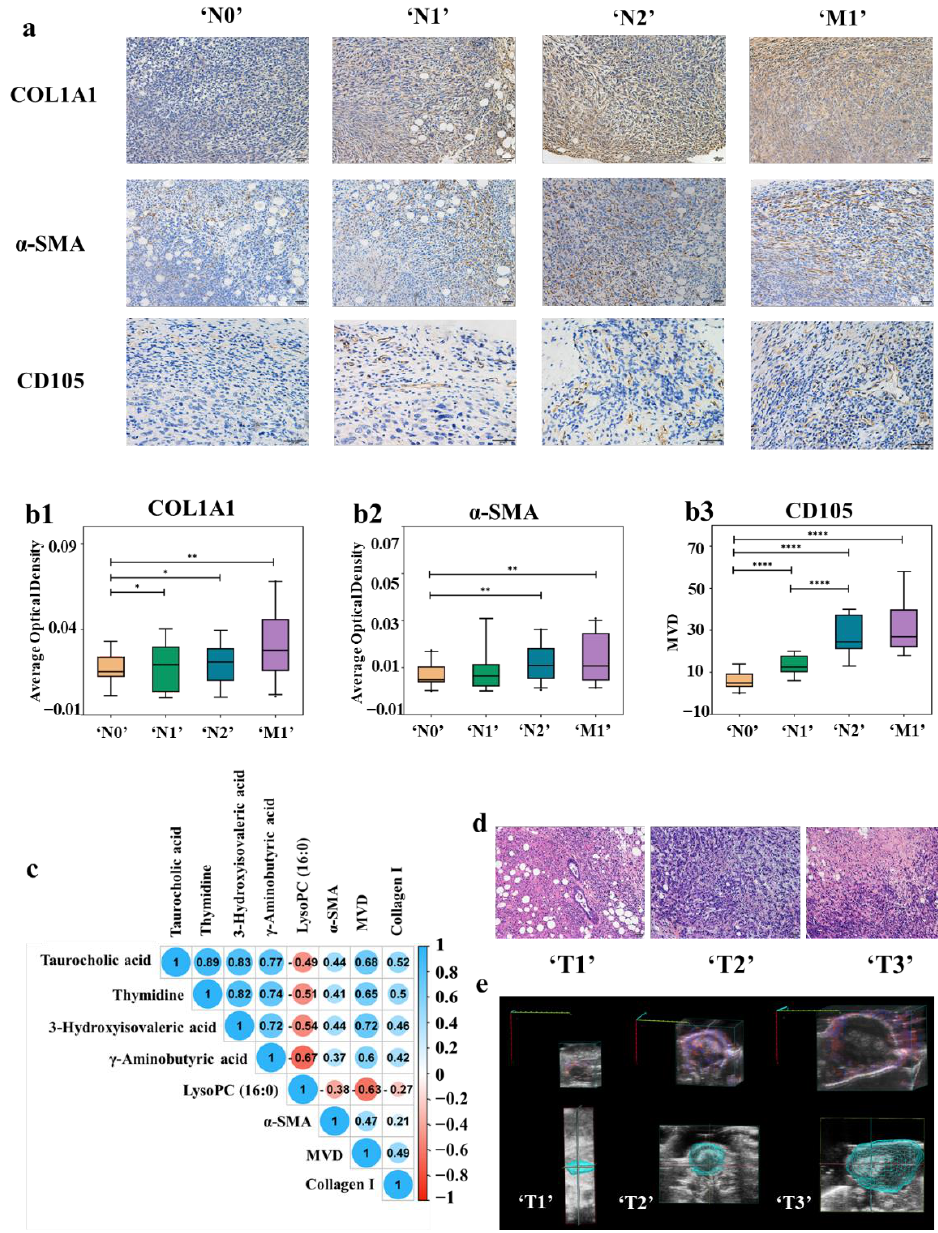
Figure 4. ( a ) Immunohistochemistry with anti-collagen I, anti- α -SMA, and anti-CD105 antibody in tumor tissues of ‘N0’ ( n = 11), ‘N1’ ( n = 8), ‘N2’ ( n = 14) and ‘M1’ ( n = 12) stages BC mouse model. With the deepening of the degree of tumor metastasis, the expression of collagen I and α -SMA as well as the MVD increased. ( b1 – b3 ) The expression of collagen I ( b1 ) and α -SMA ( b2 ) were shown by the average optical density (AOD). CD105 ( b3 ) is used to label MVD, (* p < 0.05, ** p < 0.01, **** p < 0.0001) ( c ) Correlation analysis between differential metabolites contents and protein expression in the TME. ( d ) Histopathologic staining of tumor tissues with different ‘T’ stages. ( e ) Observation of the distribution of blood vessels of BC mouse model with different ‘T’ stages by color doppler